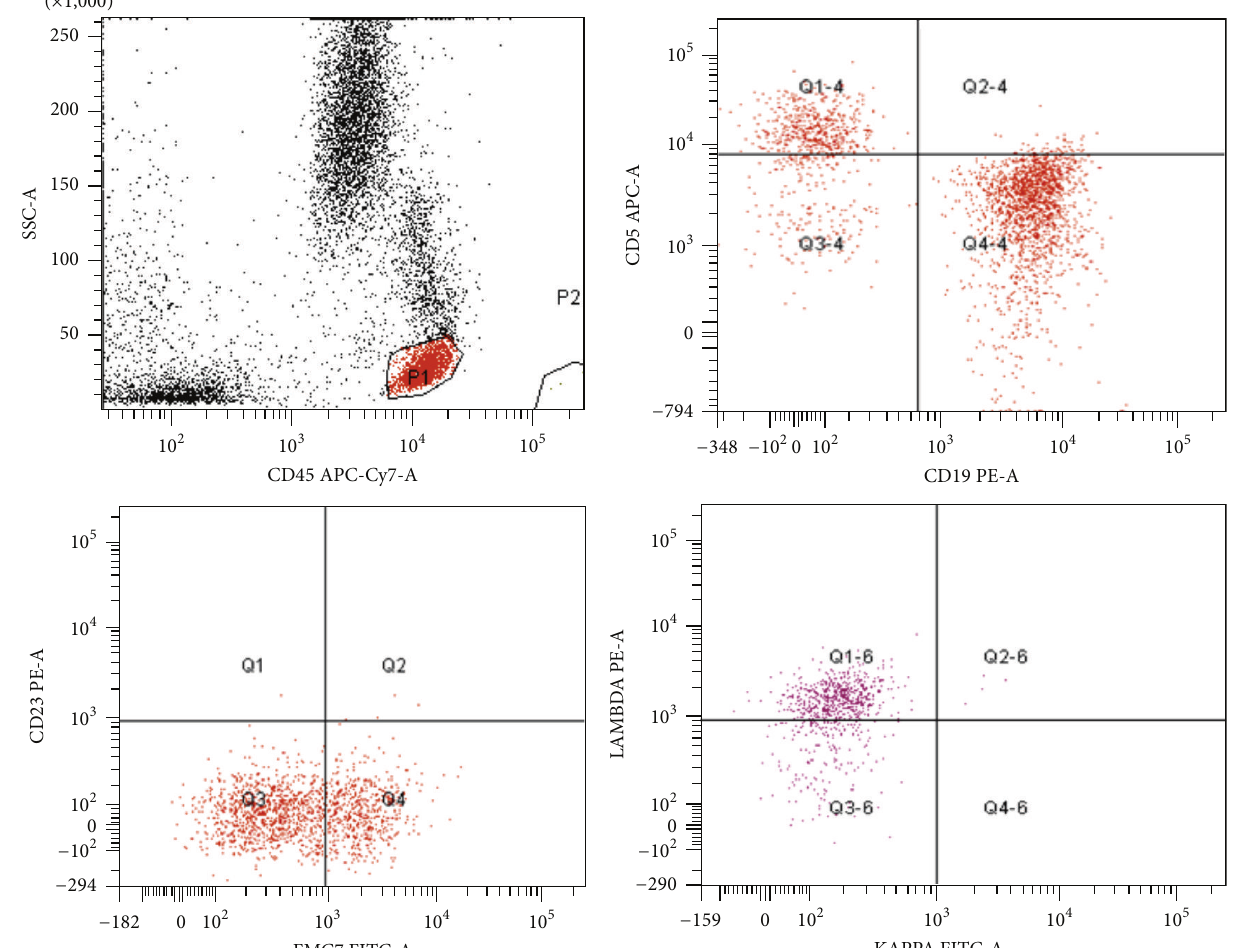
Figure 3: Flow cytometry analysis using side scatter/CD45 gating strategy; the gated population of cells (red) show bright CD45 positivity with expression of CD19 and FMC7 (45%) monotypic lambda light chain. These cells were negative for CD10, CD5, CD23, and